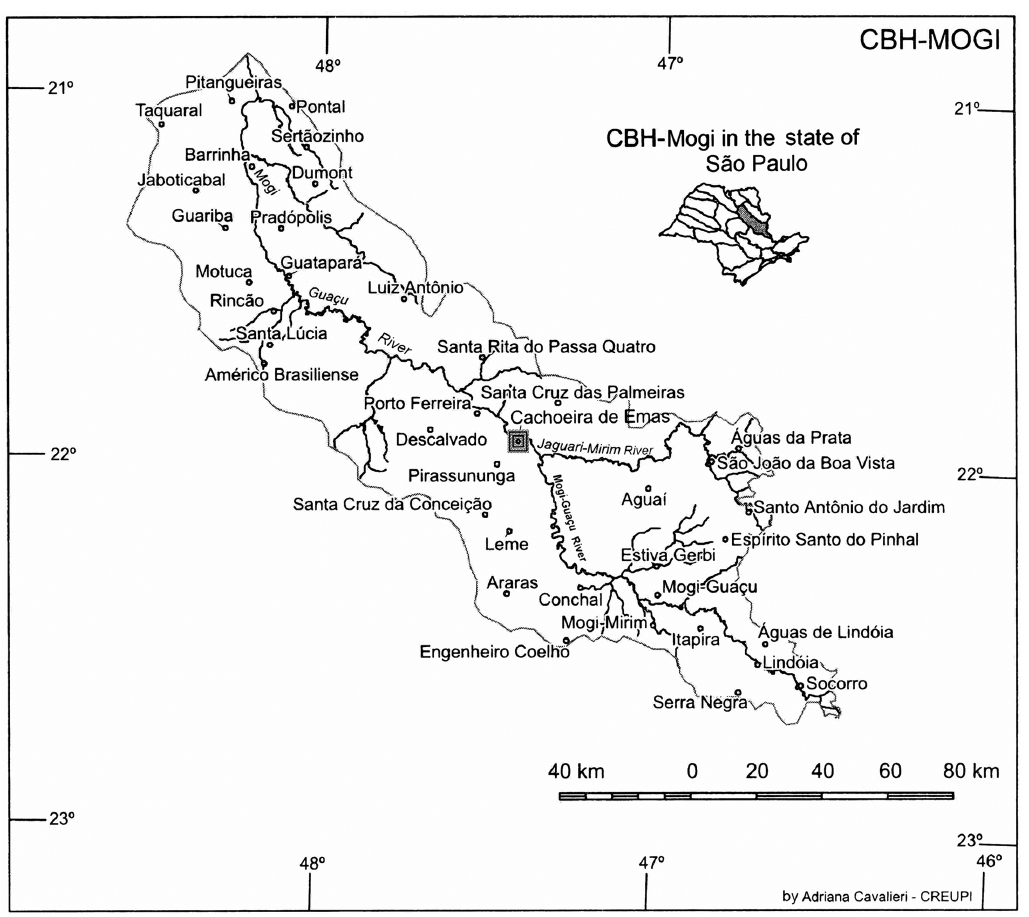
Fig. 1 – Location of Cachoeira de Emas in Mogi-Guaçu River basin inside the state of São Paulo. Adapted from CBH-Mogi and CREUP (1999).